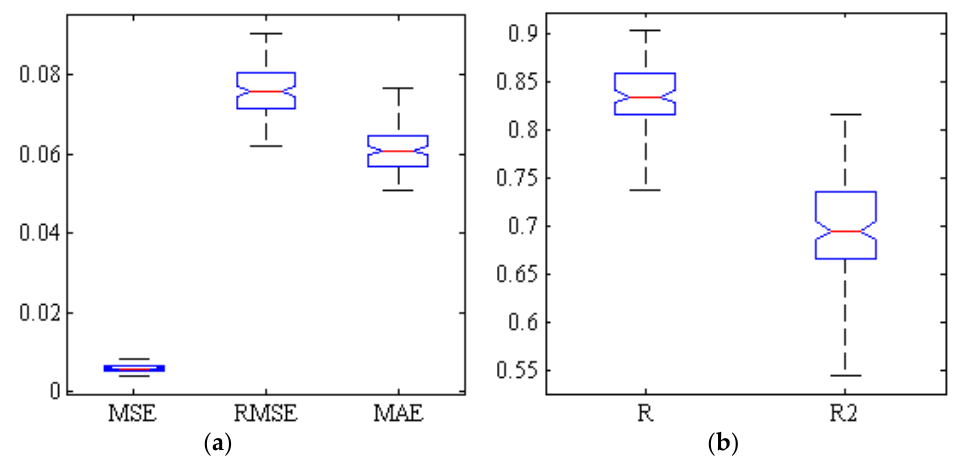
Figure 7. Box diagram of five criteria evaluating the performance of PLSR method for estimating the TA of Gala cultivar based on spectral data of key wavelengths in 300 iterations. ( a ) Error criteria, ( b ) Correlation coefficients and determination.